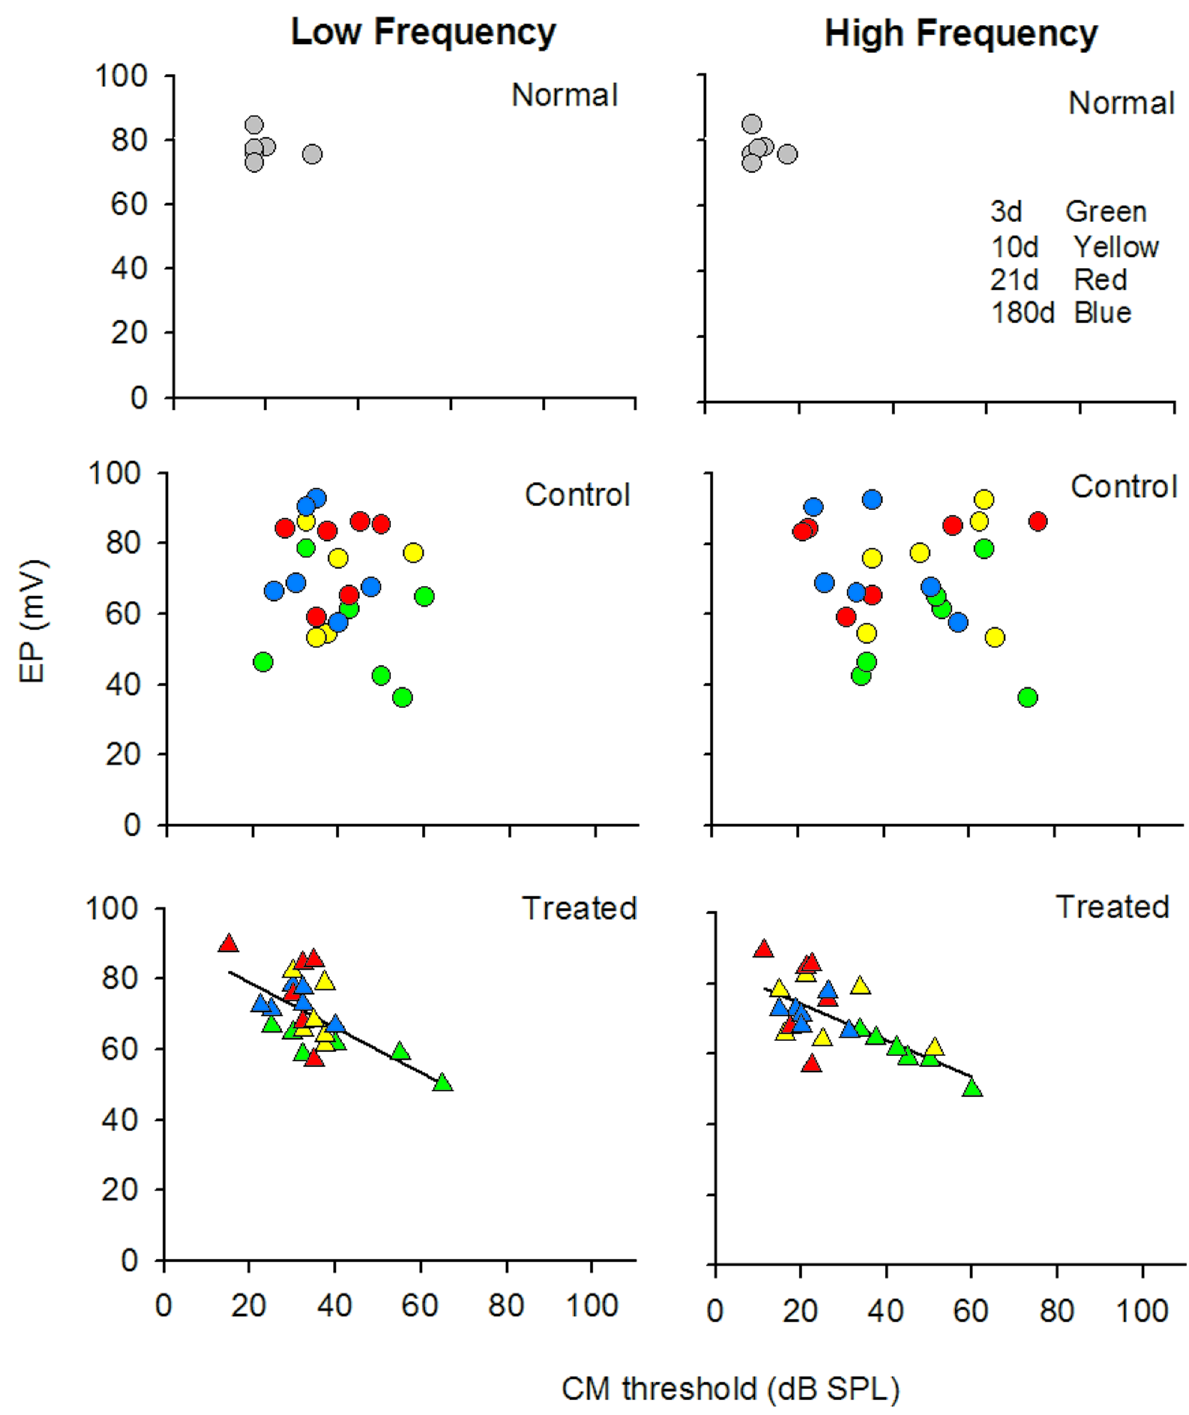
Fig 7. Bivariate analysis of the relationship between CM thresholds and EP for noise-exposed chinchilla in the HPN-07-treated and untreated groups (control). Data for low frequency (LF = 0.5 and 2 kHz); and high frequency (HF = 2, 4, 6, 8) kHz) were analyzed separately. Linearcorrelationanalysisdetected a correlationbetweenEP and CM the in both the LF (r = 0.623, n = 24;) and HF (r = 0.676, n = 24) groups that were treated with HPN-07 followingnoise exposurebut no correlationwas detected in the untreatednoise- exposed(n = 24)